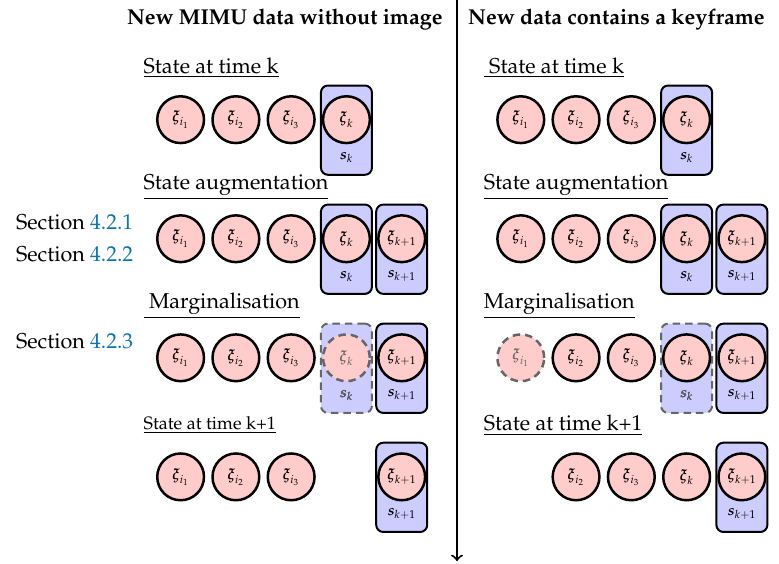
Figure 3. Illustration of state augmentation and marginalization across time as described in Section